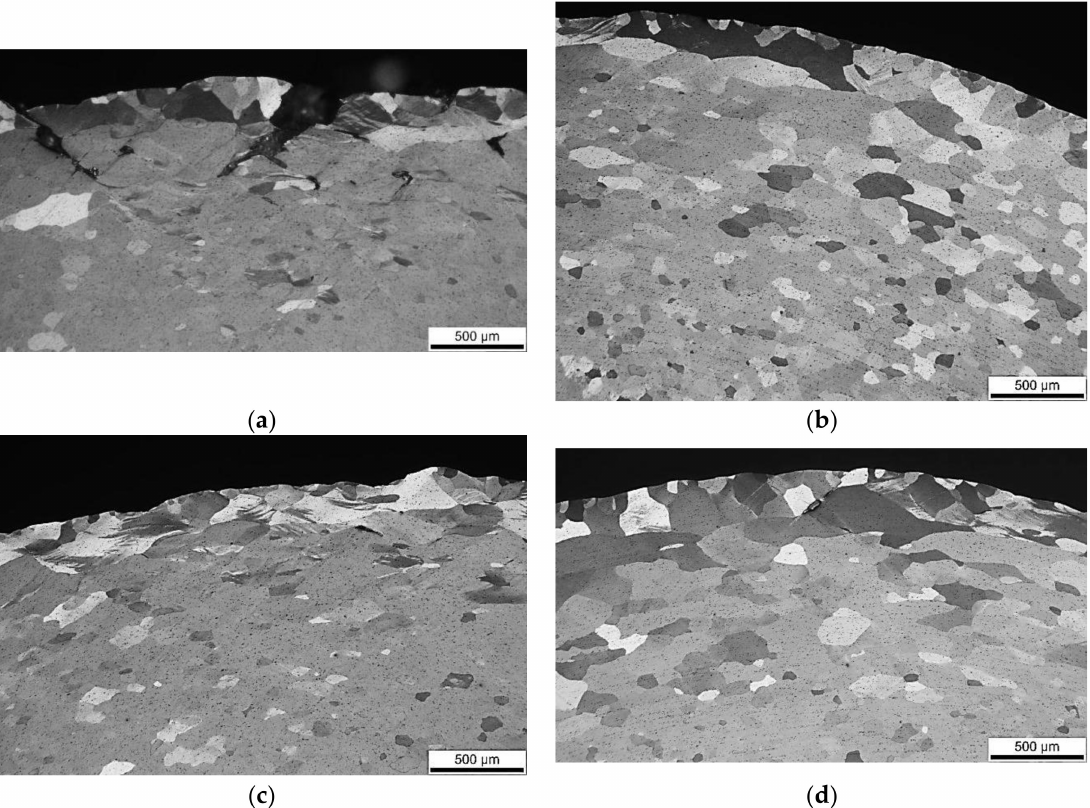
Figure 9. Bent specimens with tests being interrupted at 10% load drop, optical micrographs, polarized light illumination. Cross-section transverse to bending line showing roughening of the outer surface, shear bands formation and intergranular cracking initiation. ( a ) Sample 2.9 mm thickness (transverse test), ( b ) sample 2.9 mm thickness (longitudinal test), ( c ) sample 3.2 mm thickness (transverse test) and ( d ) sample 3.2 mm thickness (longitudinal